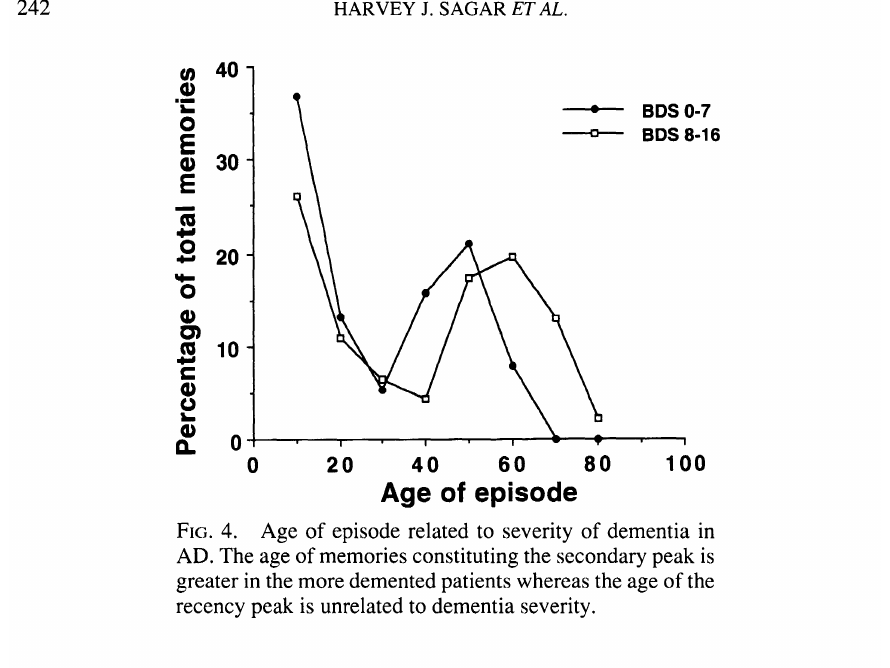
FIG. 4. Age of episode related to severity of dementia in AD. The age of memories constituting the secondary peak is greater in the more demented patients whereas the age of the recency peak is unrelated to dementia